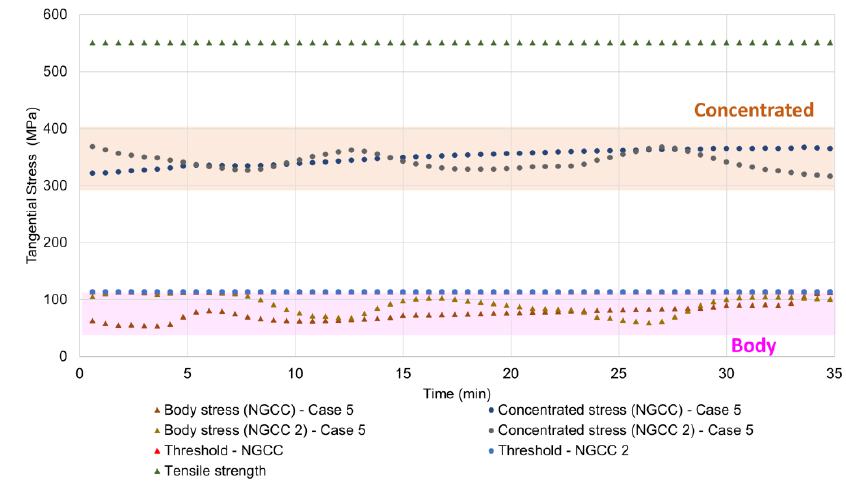
Figure 20. Drum body and concentrated tangential stresses during dispatch for Case 5.